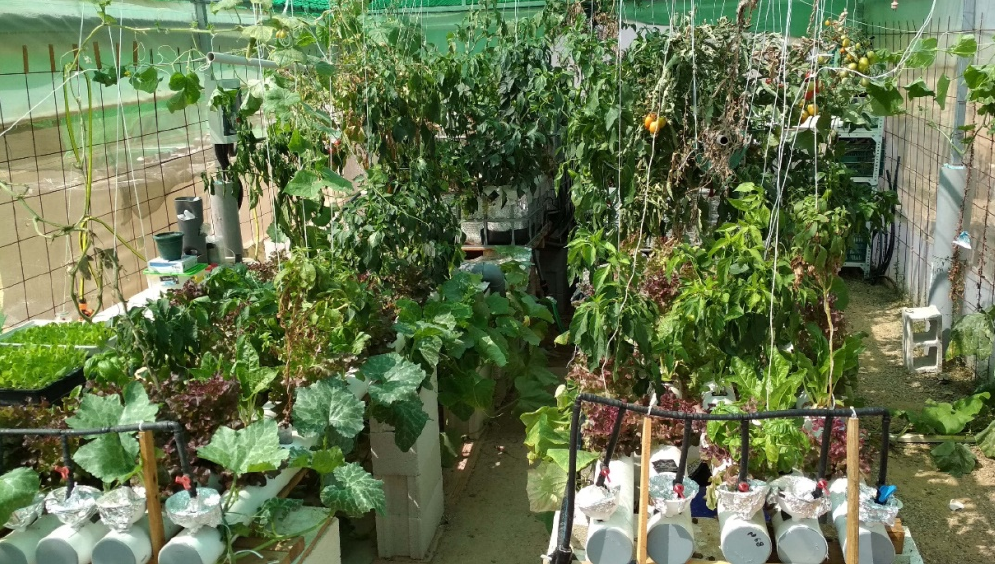
Figure 1. Small-scale aquaponic systems located at the IES Joaquín Romero Murube secondary school (Seville, Spain) in full production.